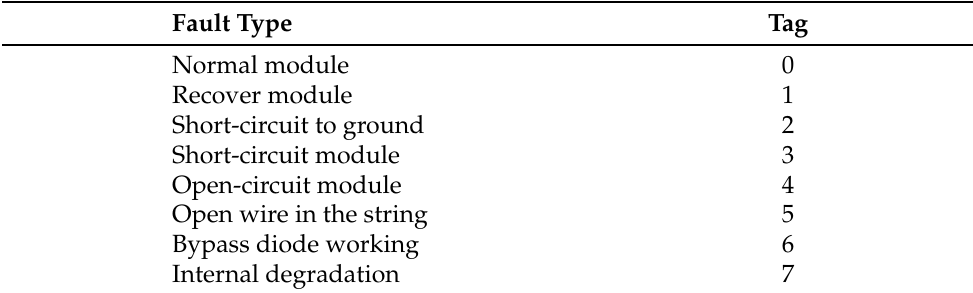
Figure 5. Modular design of the m × 3 switching box. Table 2. Tags for fault